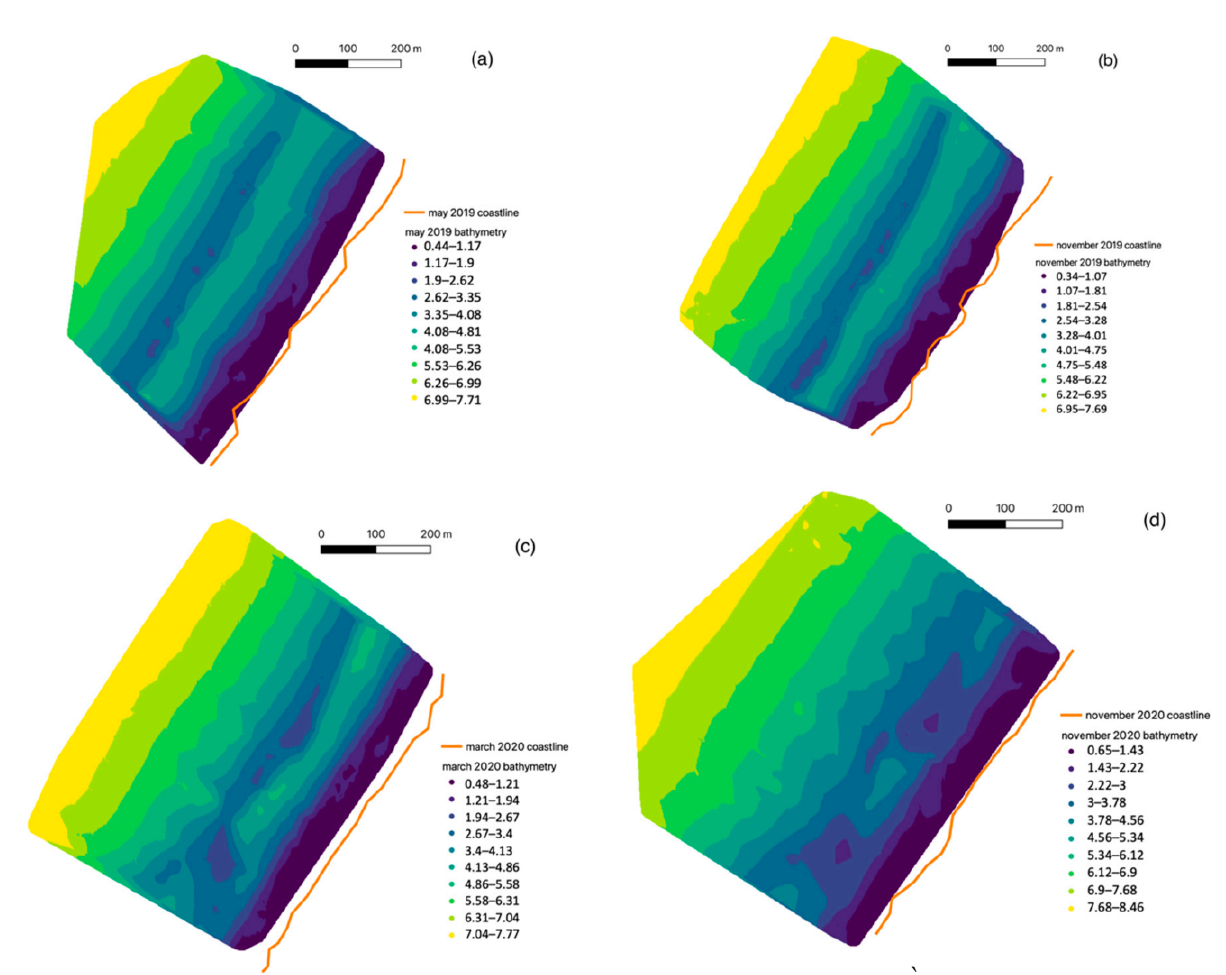
Figure 4. Bathymetry maps obtained during expeditions in 2019–2020. ( a ) 23 May 2019, ( b )